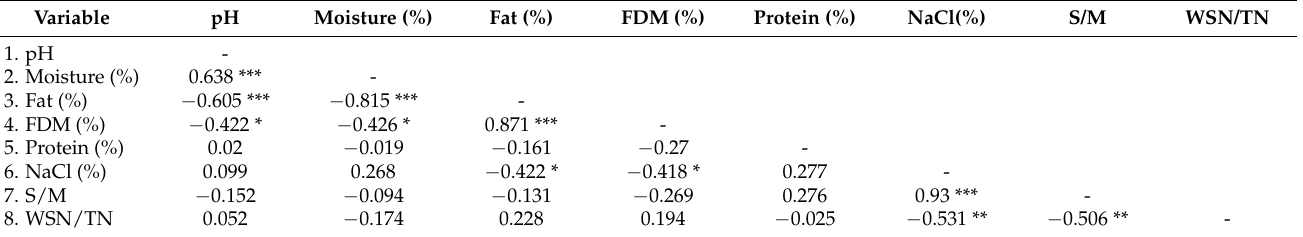
Table 3. Pearson correlation coefficients between physicochemical parameters for raw